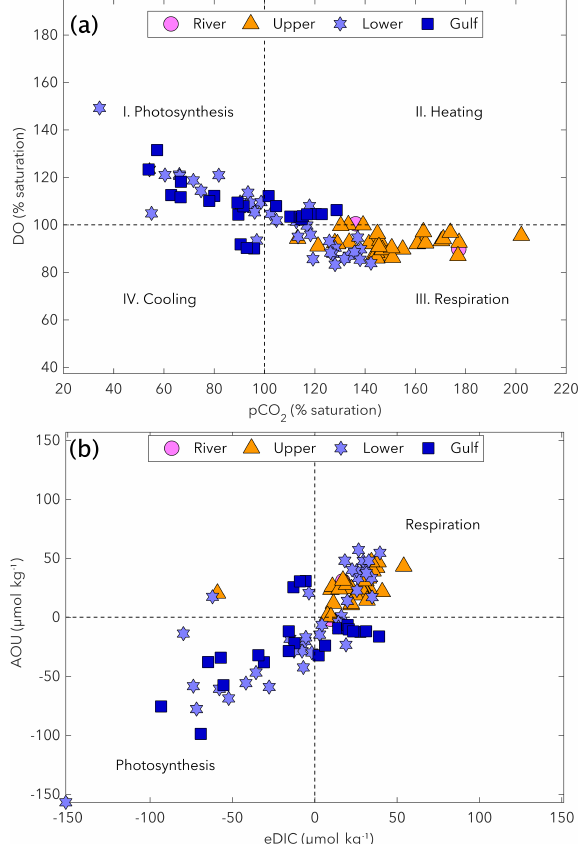
Figure 8. (a) Comparison of the saturation states (or percent sat- uration) of p CO 2 and DO in the mixed-layer waters of the St. Lawrence River, SLE, and GSL. Dashed lines delineate the 100% saturation levels for both gases. Surface-water samples (markers) fall into one of four quadrants representing the dominant controls on CO 2 / O 2 dynamics. Quadrants I and III indicate the effects of photosynthesis and respiration, whereas Quadrants II and IV indi- cate heating and cooling. Panel (b) presents a comparison of the apparent oxygen utilization (AOU) and excess DIC (eDIC). Respi- ration and remineralization processes are reflected in positive val- ues of AOU and eDIC, whereas the effects of photosynthesis are reflected in negative values.